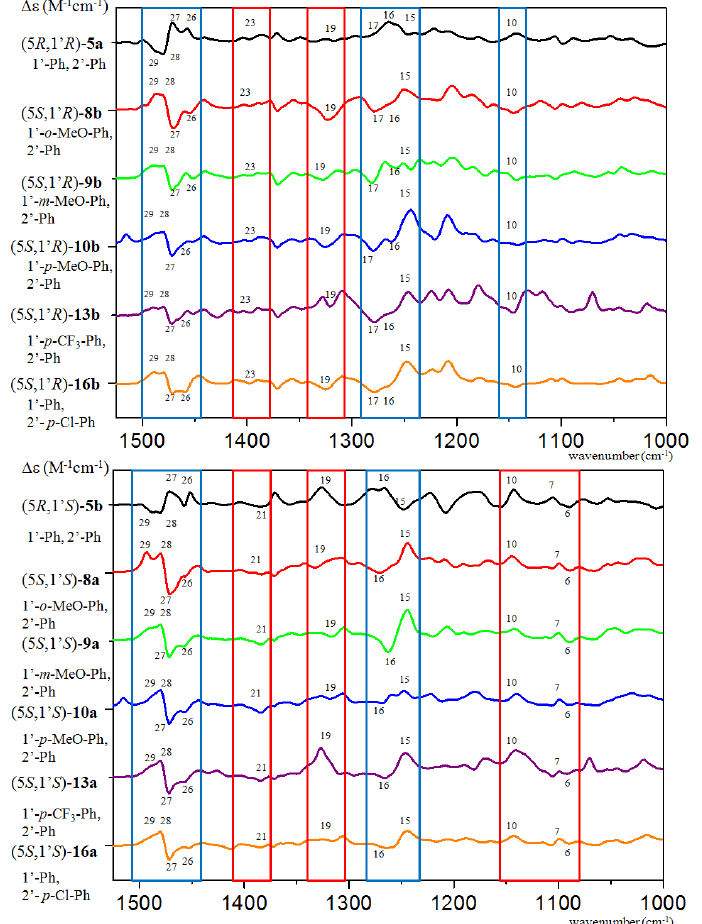
Figure 4. Experimental VCD spectra a) of (5 R ,1 ′ R ) ‐ 5a compared with those of (5 S ,1 ′ R ) ‐ 8–10b , 13b and 16b in CDCl 3 , and b) of (5 R ,1 ′ S ) ‐ 5b compared with those of (5 S ,1 ′ S ) ‐ 8–10a , 13a and 16a in CDCl 3 .